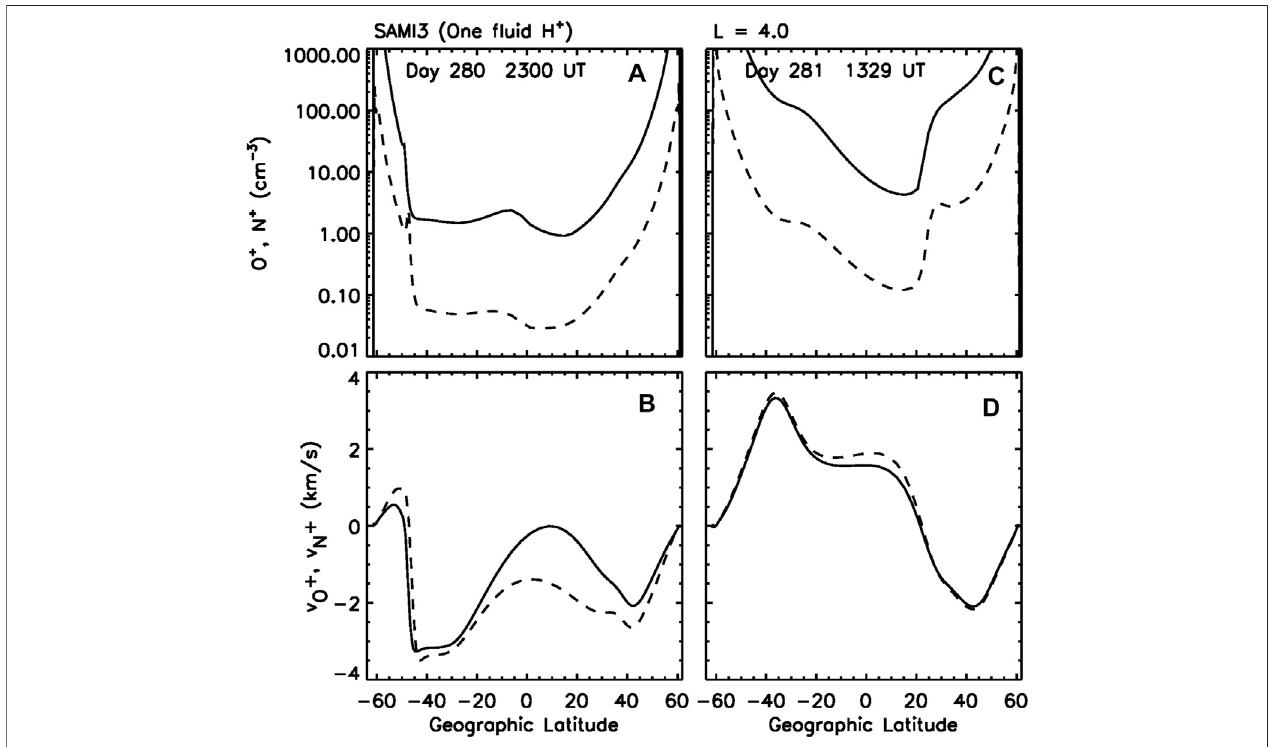
FIGURE 5| O + (solid) and N + (dashed) ion densities (A, C) and velocities (B, D) plotted versuslatitudealonga fi xed-longitude (0.5 ° ) L (cid:2) 4 fi eld line at Day 280 2300 UT (A,B) andDay2811329UT (C,D) fromtheSAMI3(one fl uidH + )simulation.Panels (A,B) areatthesametimeaspanel (B) of Panel4 .Theweakhighaltitudedensity peak in panel (A) (and Panel 4B ) occurs at a time when the upward daytime fl ows have not yet entirely reversed, panel (B)